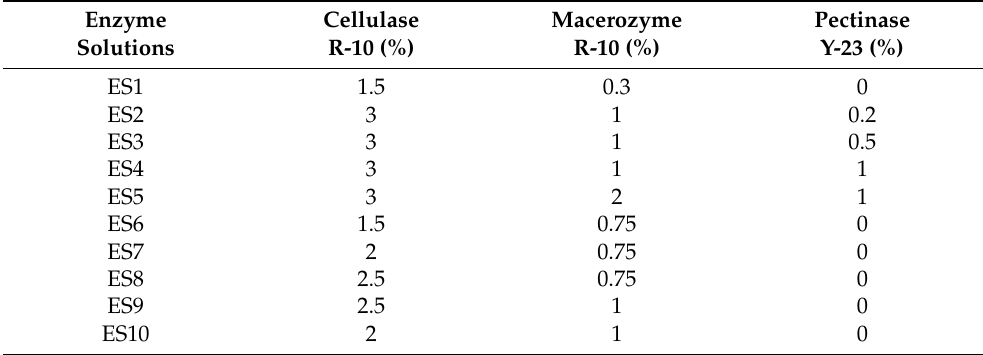
Table 1. Enzyme combinations in solutions tested for the banana protoplast isolation. Enzyme Cellulase Solutions R-10